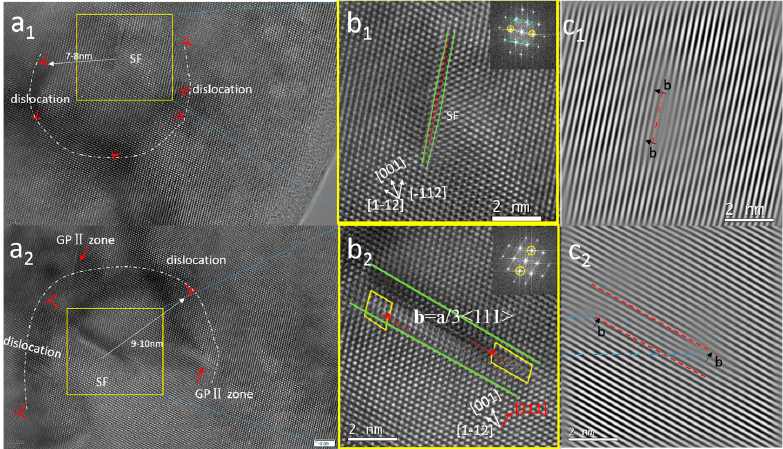
Figure 2. HREM images of rolled 7075 Al alloys after aging at 70 °C for 75 h; ( a 1 , a 2 ) HREM images of stacking faults surrounded by dislocations and GP II zones; ( b 1, b 2 ) the magnified pictures of the square in ( a 1 , a 2 ) show inserted atomic planes along [ − 112] direction; ( c 1, c 2 ) IFFT images of (111) patterns show inserted (111) planes.